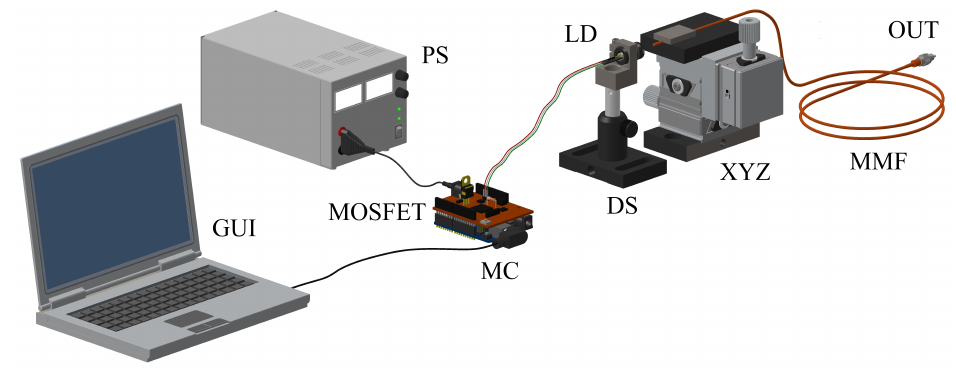
Figure 2. Experimental setup: graphical user interface (GUI), microcontroller (MC), power supply (PS), MOSFET transistor (MOSFET), CW laser diode (LD), diode support (DS), XYZ platform (XYZ), multimode fibre (MMF), laser output